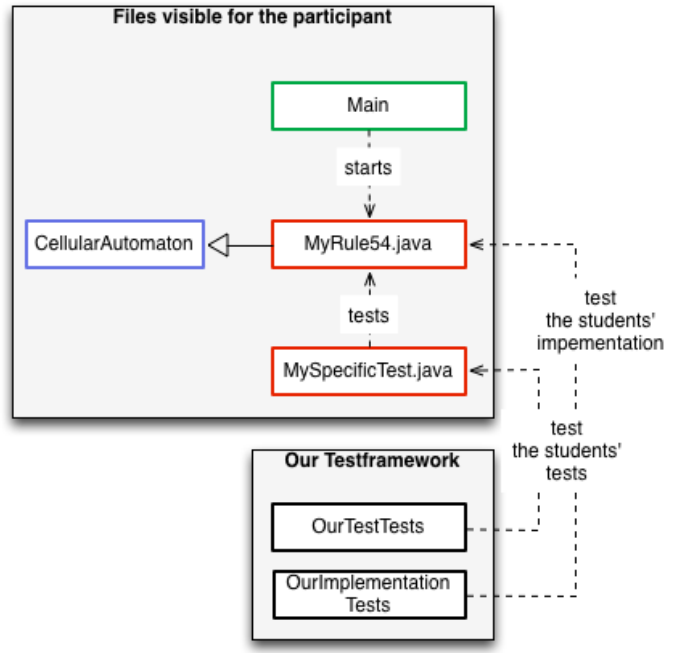
Fig. 2. Next to the part that is visible to the participants, the assignment contains a hidden part, which mainly consists of two types of tests: 1. tests that test the behaviour of the partic- ipants’ implementation and 2. tests that test if the tests that have been provided by the participants test the correct things. They have to catch a certain amount of errors and have to pass against the correct implementation. The files that have been provided to the students were an abstract class that defined the required methods to be implemented (blue border), a starter class (nothing needed to be done here-green border), and the scaffolds for a test class and the according implementation class (red border). The red- bordered classes had to be completed by the